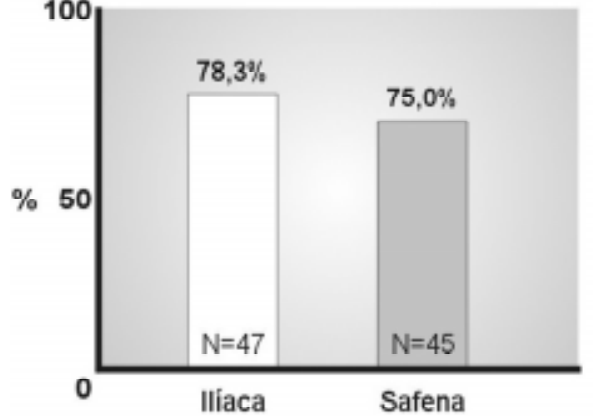
Fig. 2 - Correlation between iliac valvular and ostial saphenous vein